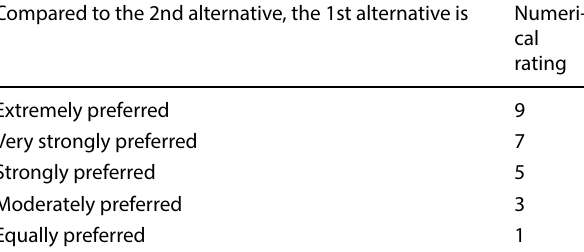
Table 3 Comparison matrix for evaluating the alternatives Compared to the 2nd alternative, the 1st alternative